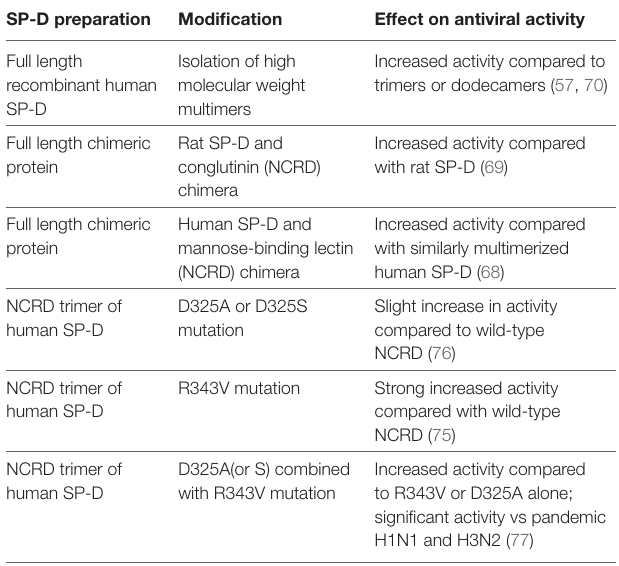
TABLe 1 | Modifications of SP-D found to increase or broaden antiviral activity for